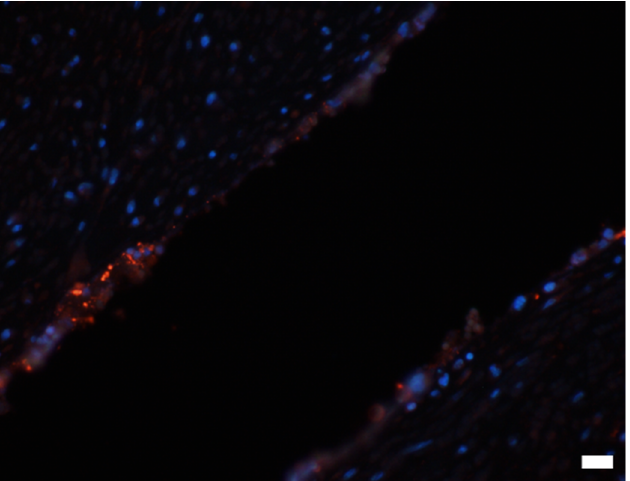
Figure 4. Detection of streptococci in close contact to endothelial cells of vascular structure, located in the surrounding tissue of the abscess capsule. 400× g magnification, bar = 20 μ m. Nuclei of cells were detected with the DNA-binding dye DAPI (blue).